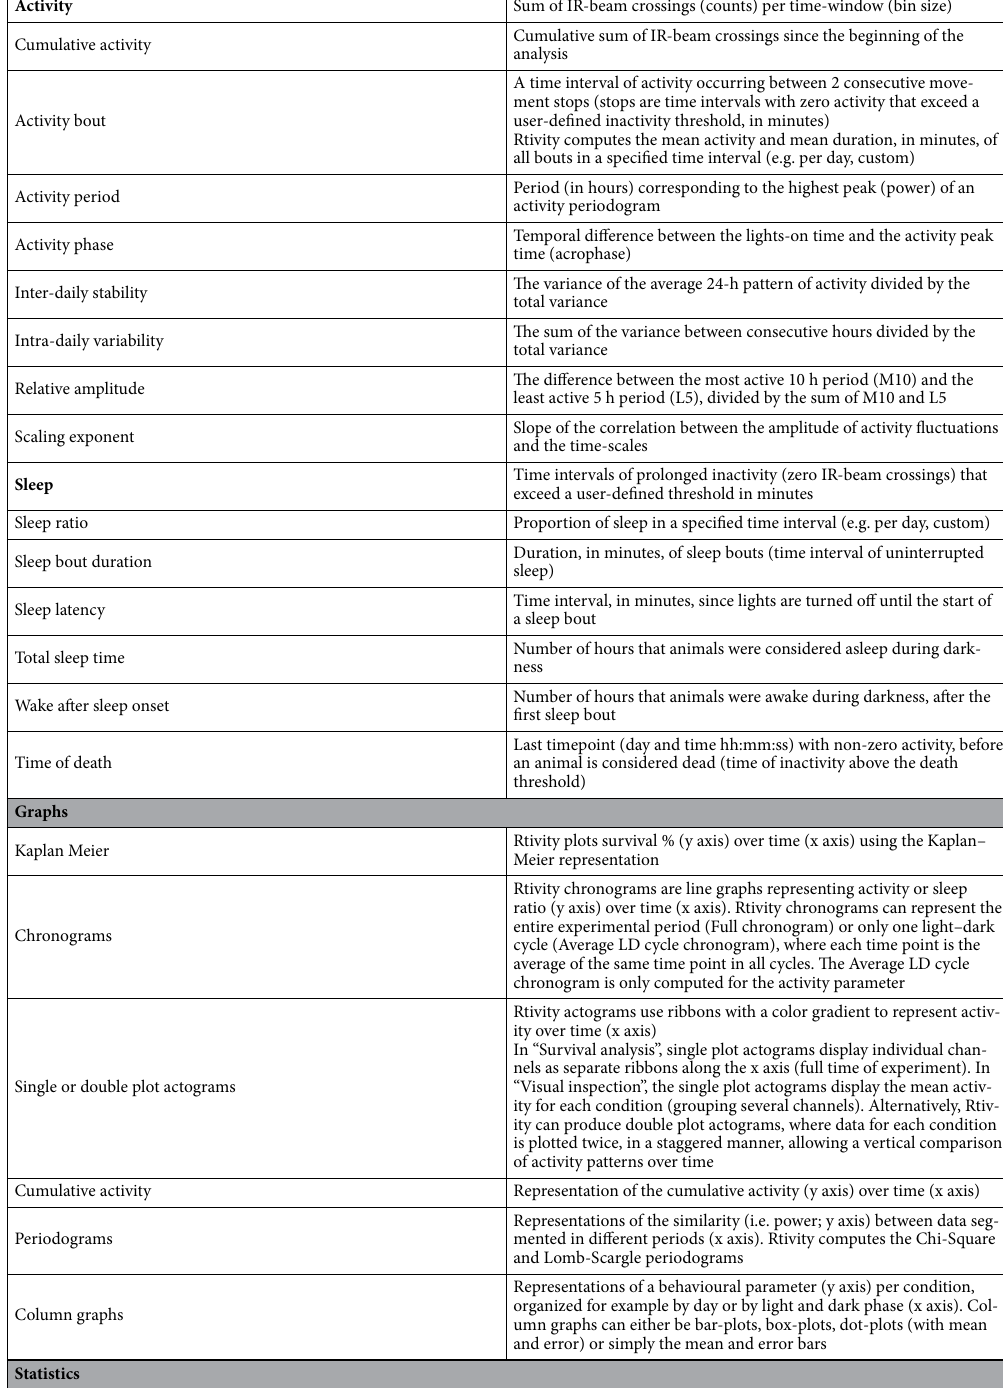
Table 1. Behavioural parameters, graphs, and statistics automatically computed by